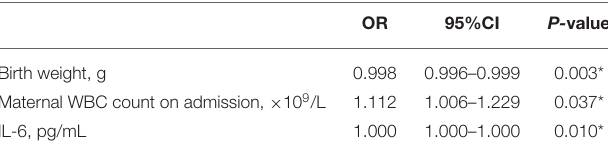
TABLE 5 | Multivariable logistic regression analysis showing the relationship between independent variables and the risk of BPD in infants with BPD and control